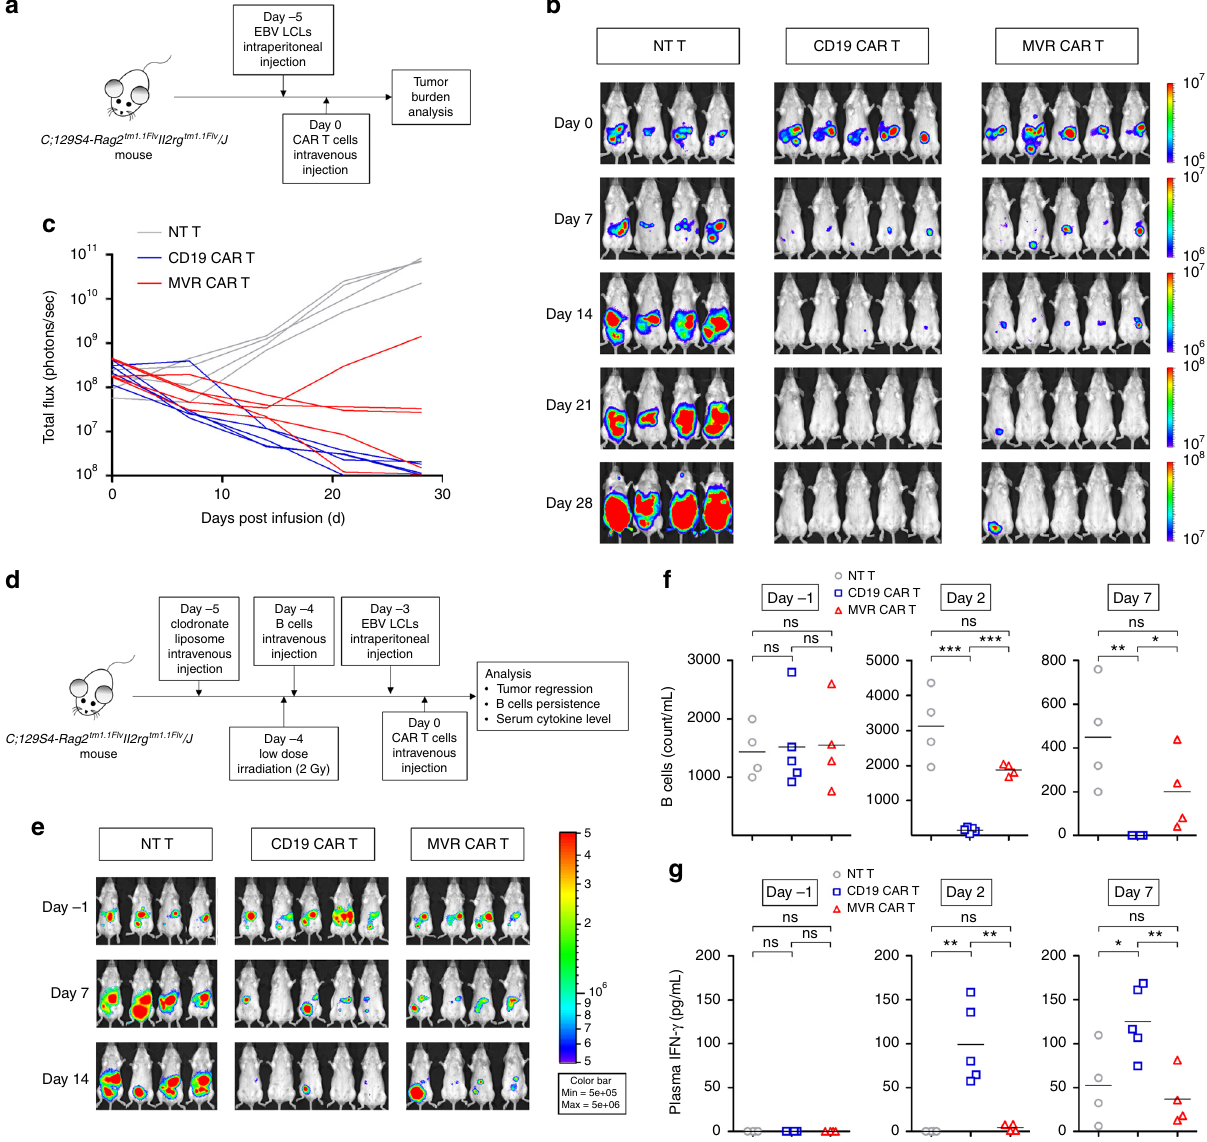
Fig. 5 Autotuned MVR CAR T cells sense antigen levels in vivo. EBV LCL-targeting speci fi city of MVR CAR T cells was veri fi ed in vivo. T cells, B cells, EBV LCLs from donors with HLA-DRB1 alleles exhibiting weak binding with MVR ( DR weak ; Fig. 1a) were used in the following experiments. a – c Ef fi cacies of DR weak EBV LCL suppression after infusion with non-transduced (NT) T, CD19 CAR T, or DR weak MVR CAR T cells. Luciferase activity in mice grafted with luciferase-labeled DR weak EBV LCLs was measured on 0, 7, 14, 21, and 28 days post-T cell infusion. a Procedure for evaluating EBV LCL suppression in vivo. Images ( b ) and total luminescence ( c ) were collected and analyzed. d Procedure of in vivo on-target killing assay. Xenografting of DR weak B cell/ DR weak EBV LCL was followed by infusion with NT T, CD19 CAR T, or DR weak MVR CAR T cells, and subsequent ef fi cacy analysis. e Ef fi cacy of EBV LCL suppression after infusion with each T cell observed for 14 days. Luciferase activity in mice grafted with DR weak B cells and luciferase-labeled DR weak EBV LCLs was measured on – 1, 7, and 14 days post-T cell infusion. f B cell persistence in T cell-infused mice on − 1, 2, and 7 days post-T cell infusion. Peripheral blood of each mouse was stained with a panel of antibodies and analyzed as described in Supplementary Fig. 7. g Plasma IFN- γ levels measured in mice infused with NT T, CD19 CAR T, or DR weak MVR CAR T cell on − 1, 2, and 7 days post-T cell infusion. a – c NT T, n = 4 mice; CD19 CAR T, n = 5 mice; MVR CAR T, n = 5 mice. d – g NT T, n = 4 mice; CD19 CAR T, n = 5 mice; MVR CAR T, n = 4 mice. f , g Horizontal lines indicate mean. f , g Unpaired two-tailed t - test: ns not signi fi cant; * p < 0.05; ** p < 0.01; *** p <